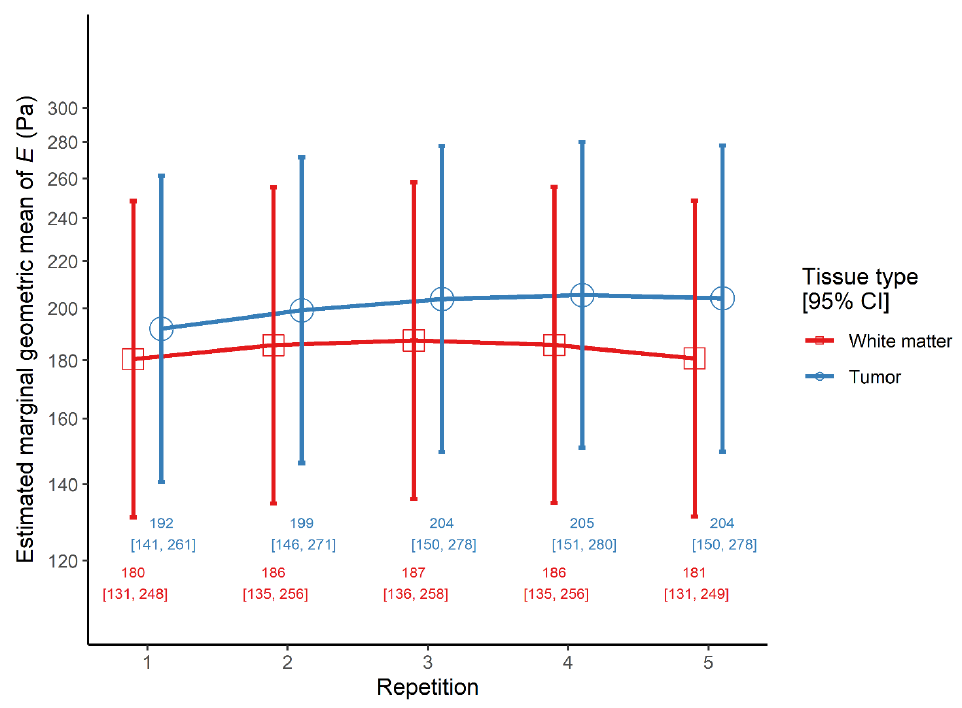
Figure 3. The interaction effect between tissue type and repetition on the elastic modulus E in the repetitive indentation model.